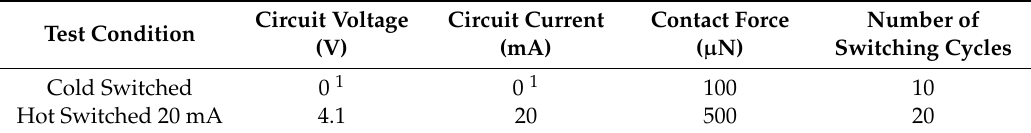
Table 3. Circuit and Force Conditions for each switching sequence.